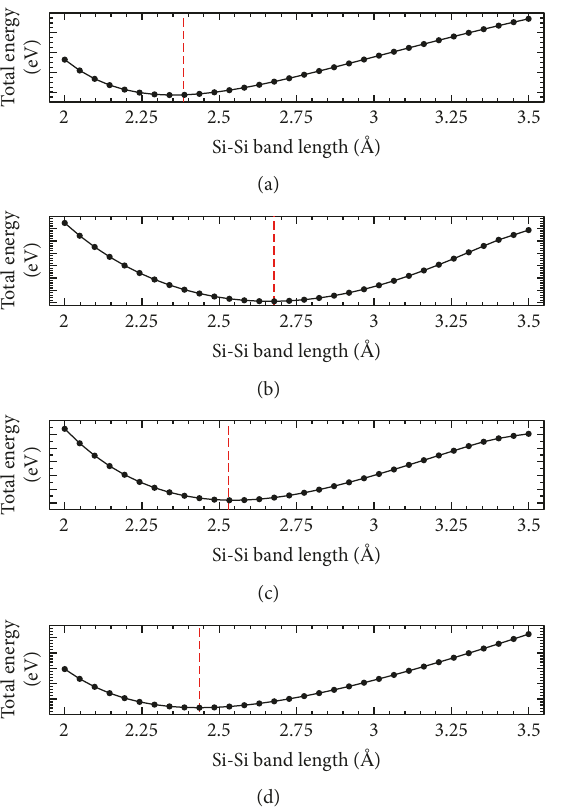
Figure 3: Total density of states (TDOS) of four clusters with ODC(I) defect. (a) Si 2 H 6 , (b) Si 2 O 6 H 6 , (c) Si 5 O 15 H 12 , and (d) Si 8 O 24 H 18 . The red vertical dashed lines align to highlight highest occupied molecular orbital (HOMO)